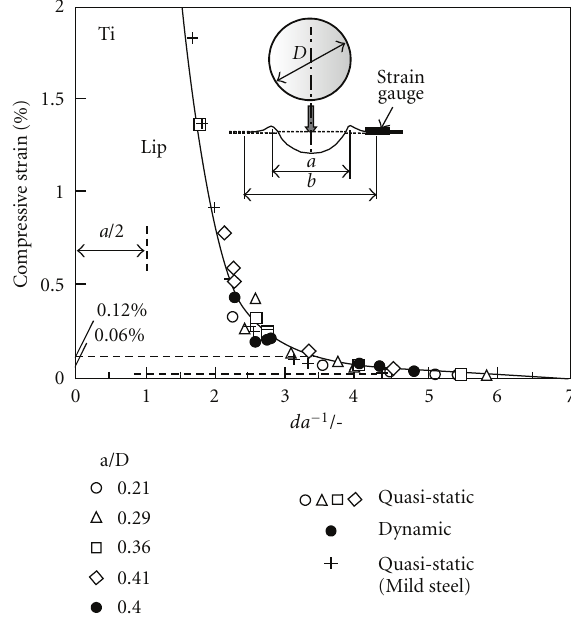
d/a in quasistatic and dynamic indentations at R.T. •◦ (cid:2) (cid:3) (cid:3) for Ti, + for mild steel.